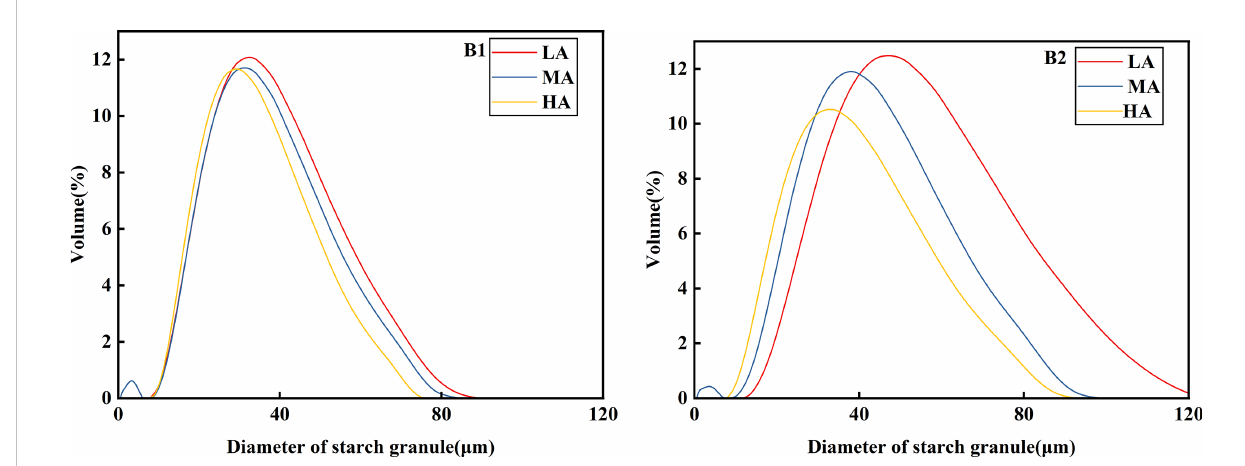
FIGURE 3 Volume distribution of potato starch granules at different altitudes. LA (low altitude), MA (middle altitude) and HA (high altitude) stand for Chongzhou, Xichang and Litang respectively; B1 and B2 stand for Jiusen No. 1 and Qingshu No. 9 respectively.